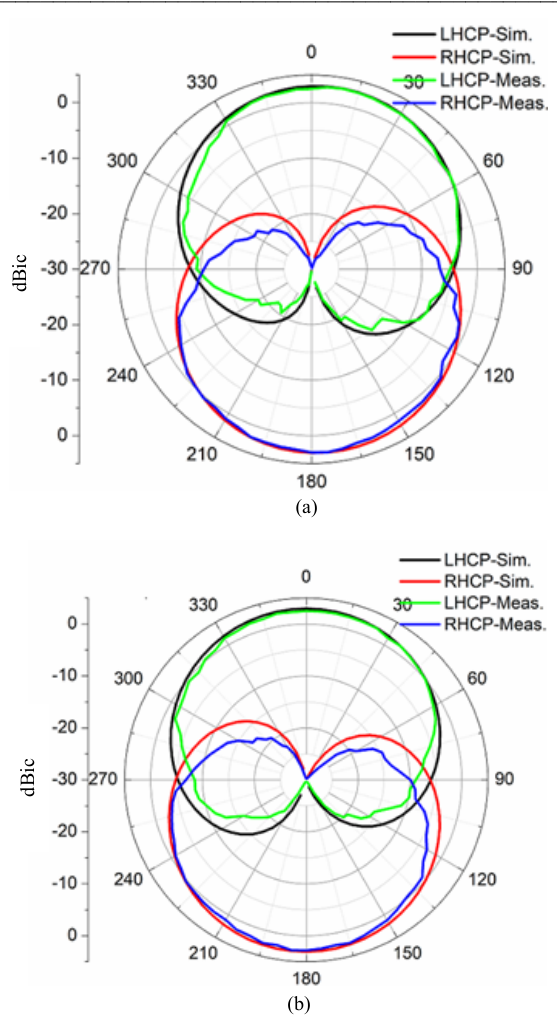
Fig. 20. Simulated and measured radiation patterns at 5.8 GHz for xz - and yz -